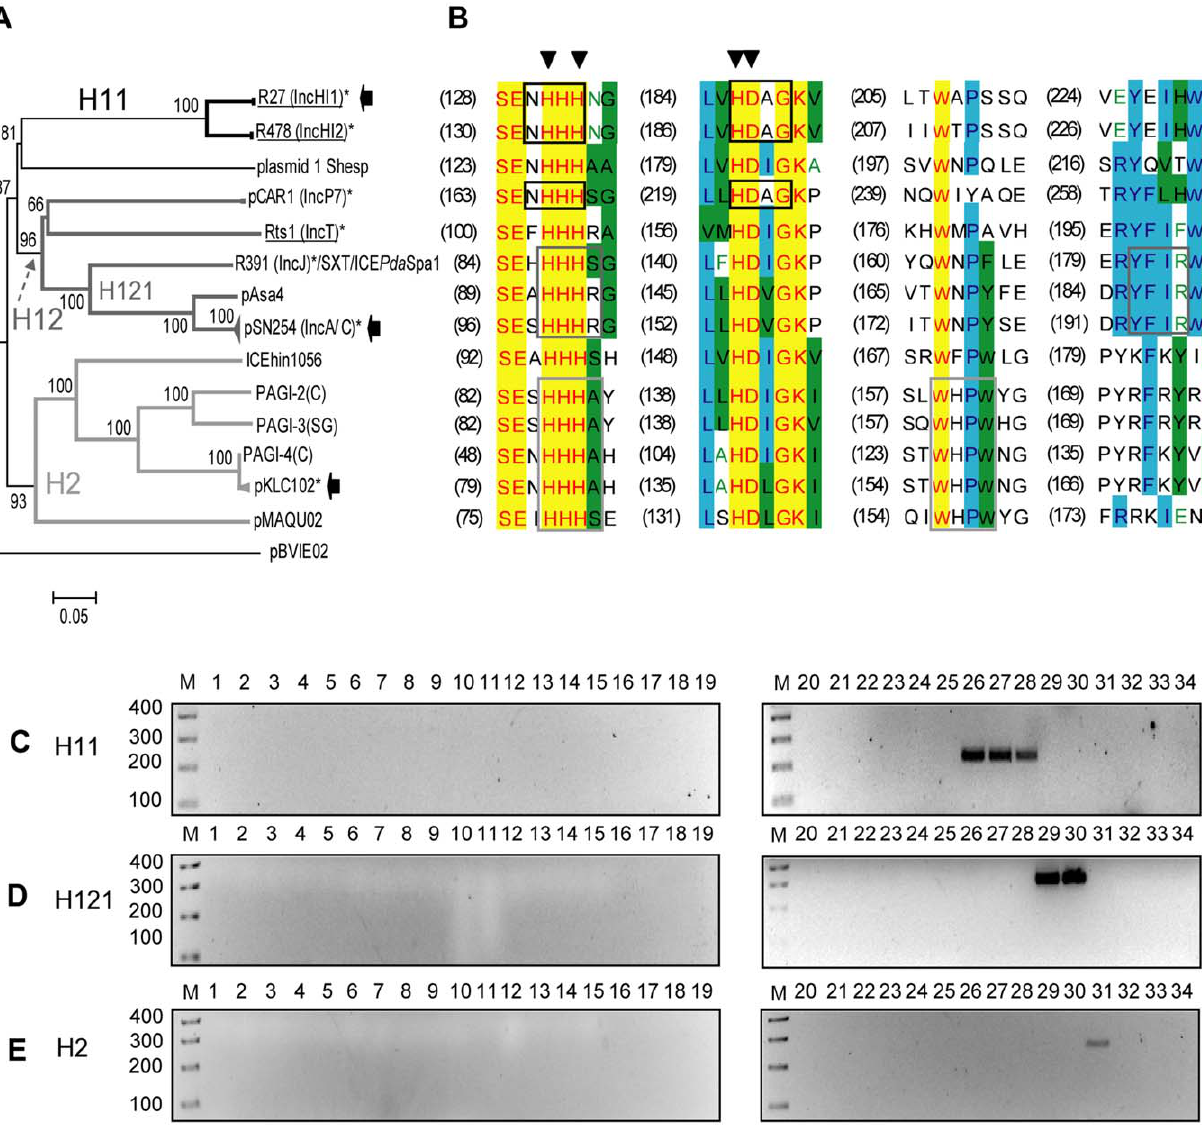
Figure 6. DPMT validation for MOB H relaxases. A) Phylogenetic tree of MOB H relaxase family. B) Alignment of the relaxase motifs used to design the MOB H degenerate primers (H11-f + H11-r, continuous black; H121-f + H121-r, continuous dark grey; and H2-f + H2-r, continuous grey). C) Amplicons obtained with primers for subfamily MOB H11 (H11-f and H11-r). D) Amplicons obtained with primers for subfamily MOB H121 (H121-f and H121-r). E) Amplicons obtained with primers for subfamily MOB H2 (H2-f and H2-r). Symbols, colour codes and lanes as in Figure 1.